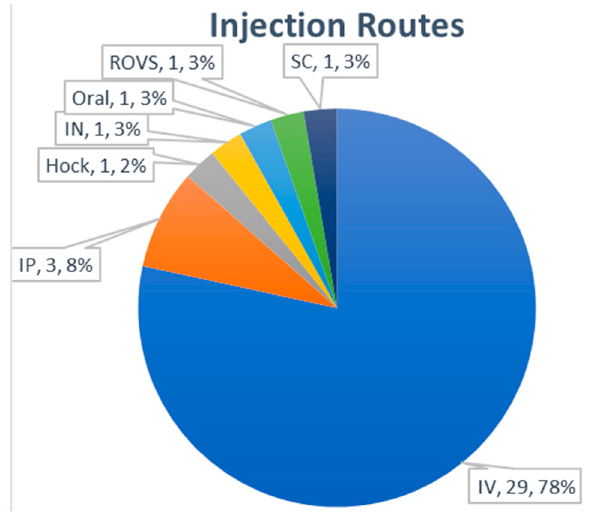
Figure 8. Administration route of exosomes for biodistribution analysis.